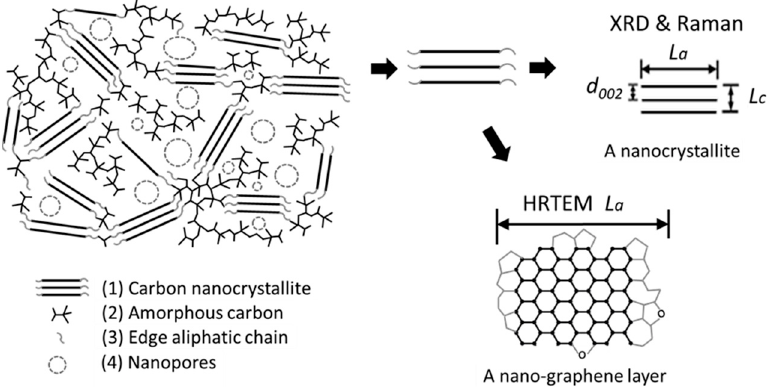
Figure 7. Schematic image of the carbon nanostructure model of KL-X samples. The KL-X samples consisted of carbon nanocrystallites, amorphous carbon, and nanopores. The nanocrystallites consisted of 2–4 layers of turbostratic stacked nano-graphene. The lateral size, thickness, and interlayer space of nano-graphene are L a , L c , and d 002 , respectively.